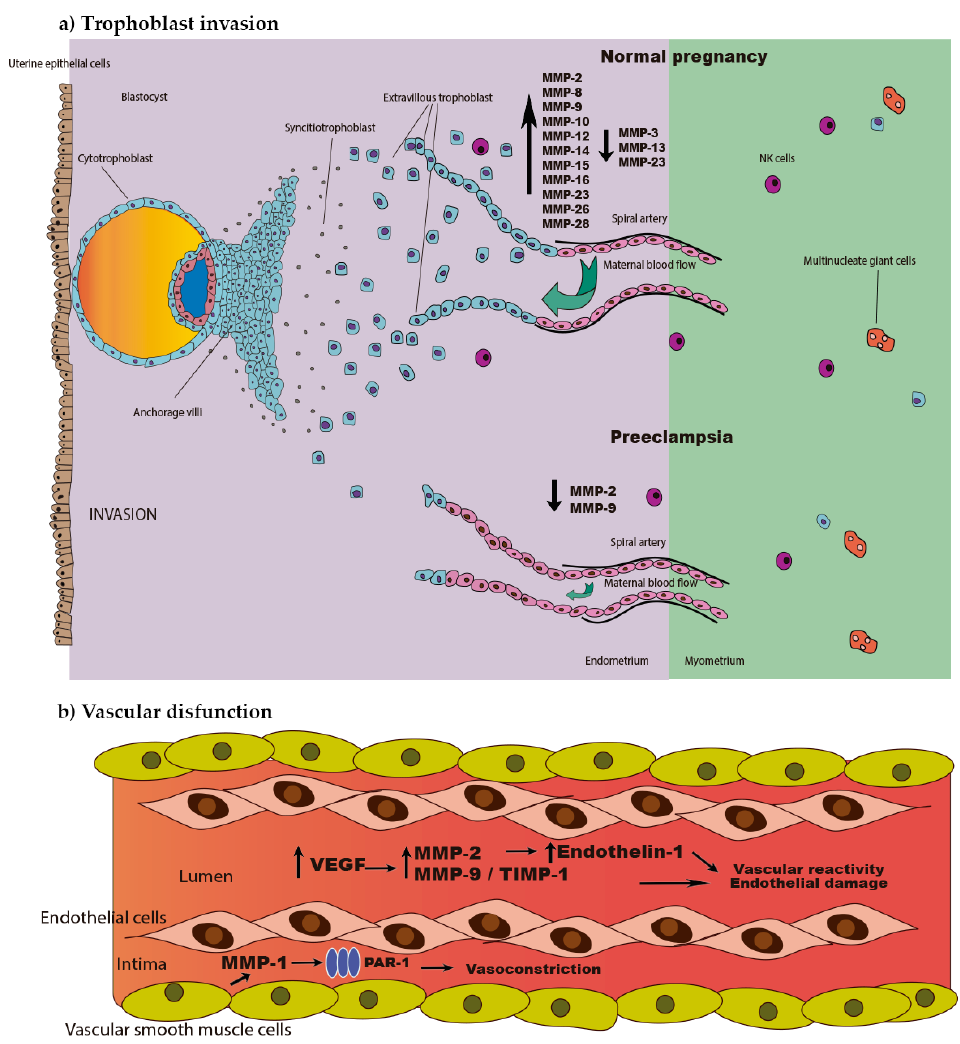
Figure 1. Role of matrix metalloproteinases (MMPs) in preeclampsia. ( a ) Impaired trophoblast invasion observed in early stage of preeclampsia is characterized by a decrease in MMP-2 and MMP-9, which affects spiral artery remodeling, causing a poorly perfused fetoplacental unit. ( b ) Vascular dysfunction developed during the late stage of preeclampsia is mediated by several MMPs including MMP-1, MMP-2 and MMP-9, which induce vasoconstriction, changes in vascular reactivity and endothelial damage. PAR-1, protease-activated receptor 1; VEGF, vascular endothelial growth factor; NK, natural killer cells; and TIMP-1, tissue inhibitor of matrix metalloproteinase-1.